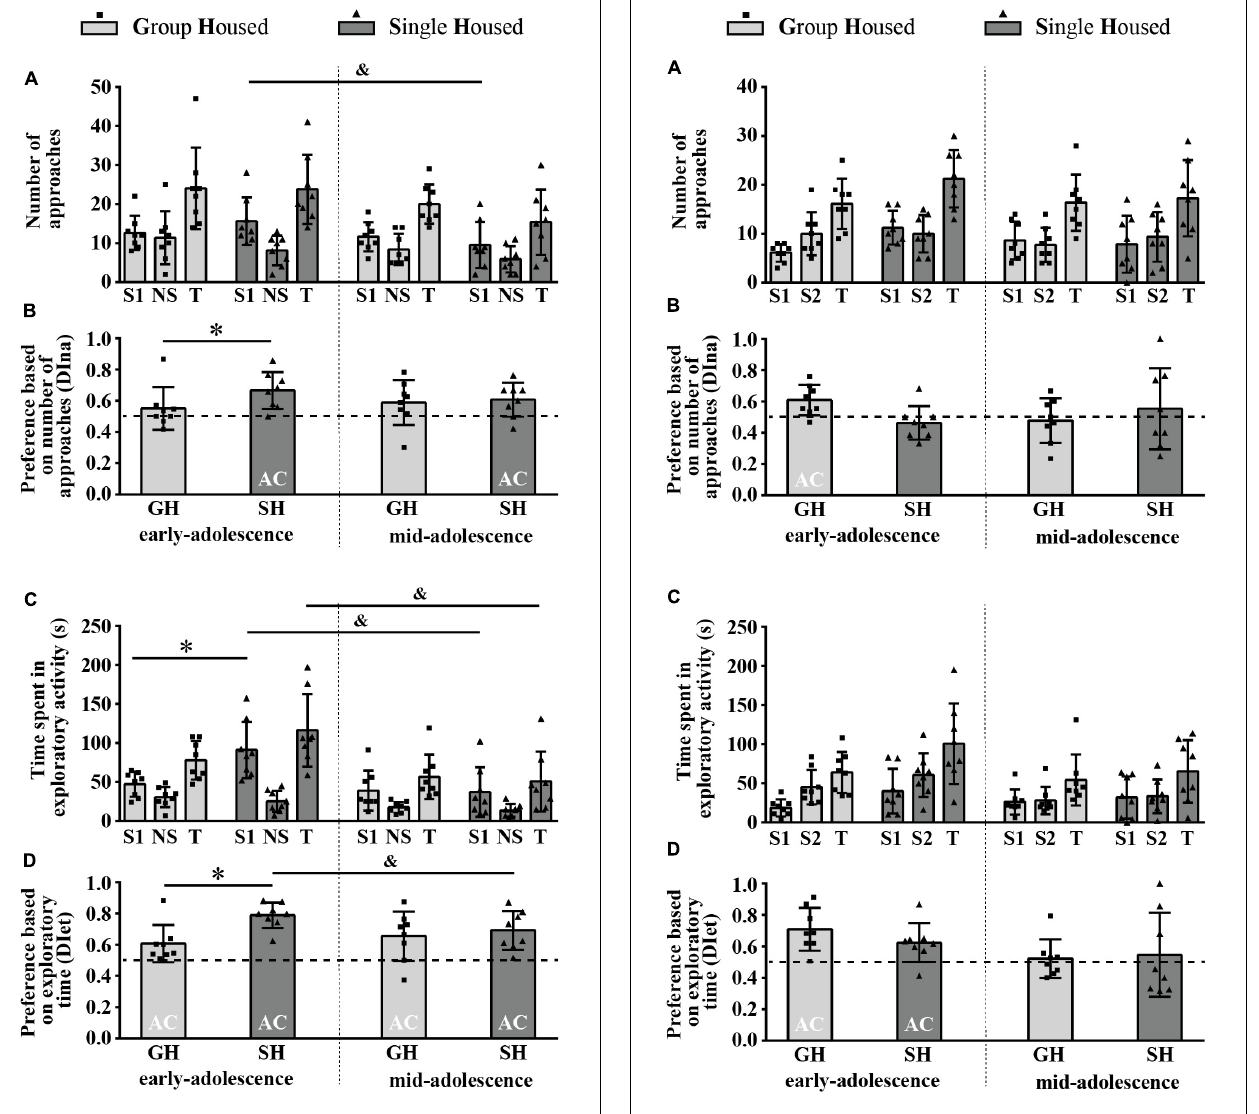
FIGURE 8 | The behavior of peripubertal male rats in a social olfactory test (the preference for novel social odor phase) at the end of the first week (early-adolescence) and the second week (mid-adolescence) of defined housing, which began on the 29th postnatal day. The data are represented as mean ± SD , with individual data plots along the column bars. (A) The number of approaches to the box with the familiar social odor (S1) and to the box with novel social odor (S2) and the total number of approaches (T). (B) The relative preference for the S2 is based on the number of approaches to the boxes. (C) The time spent in the exploration of the S1 box, the S2 box, and the total exploratory time (T). (D) The relative preference for the S2 is based on exploratory time. AC – significantly above the chance level (0.5). Statistical comparisons and exact p -values are given as Supplementary Table S1 . housing conditions, and their interaction on any of the examined parameters. The DI was above chance level (0.5) only in early- adolescent GH animals ( Figure 8B ; one-sample t -test: p = 0.016, t = 3.146, df =